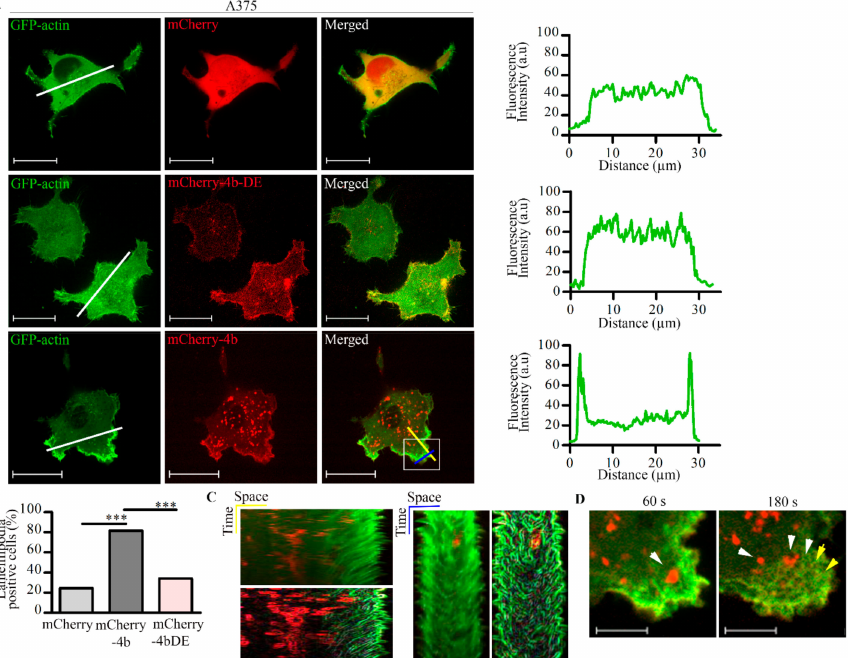
Figure 4. PMCA4b activity is necessary for lamellipodia formation in A375 melanoma cells. ( A ) A375 cells were transfected with GFP-actin together with one of the following plasmids: pmCherry-C1, mCherry-PMCA4b, mCherry-PMCA4b-DE, and cultured for 48 h. Confocal mi- croscopy images of lamellipodia are shown. Scale bar, 20 µ m. Graphs represent the GFP-actin intensity profile (green) for the line (white) drawn along the cell as indicated in the confocal image. Confocal sections were taken in the middle to visualize lamellipodia formation. ( B ) The graph shows the fraction of lamellipodia-positive cells in cultures transfected with GFP-actin and mCherry, mCherry-PMCA4b, or mCherry-PMCA4b-DE. ( C , D ) Live-cell imaging of cells expressing GFP-actin and mCherry-PMCA4b. Z-stacks of images were taken every 5 s for 5 min at 37 ◦ C using spinning- disc confocal microscopy. ( C ) Kymographs were generated along the lines (yellow and blue) of the lamellipodia of the mCherry-PMCA4b cell shown in the image in ( A ), using the ImageJ software. Fine edges of ruffles are shown. ( D ) Magnified part of the lamellipodia from the same cell shown in ( A ). White arrowheads show mCherry-PMCA4b positive vesicles and the yellow arrowheads show GFP-actin retrograde flow. Scale bar, 5 µ m (*** p <